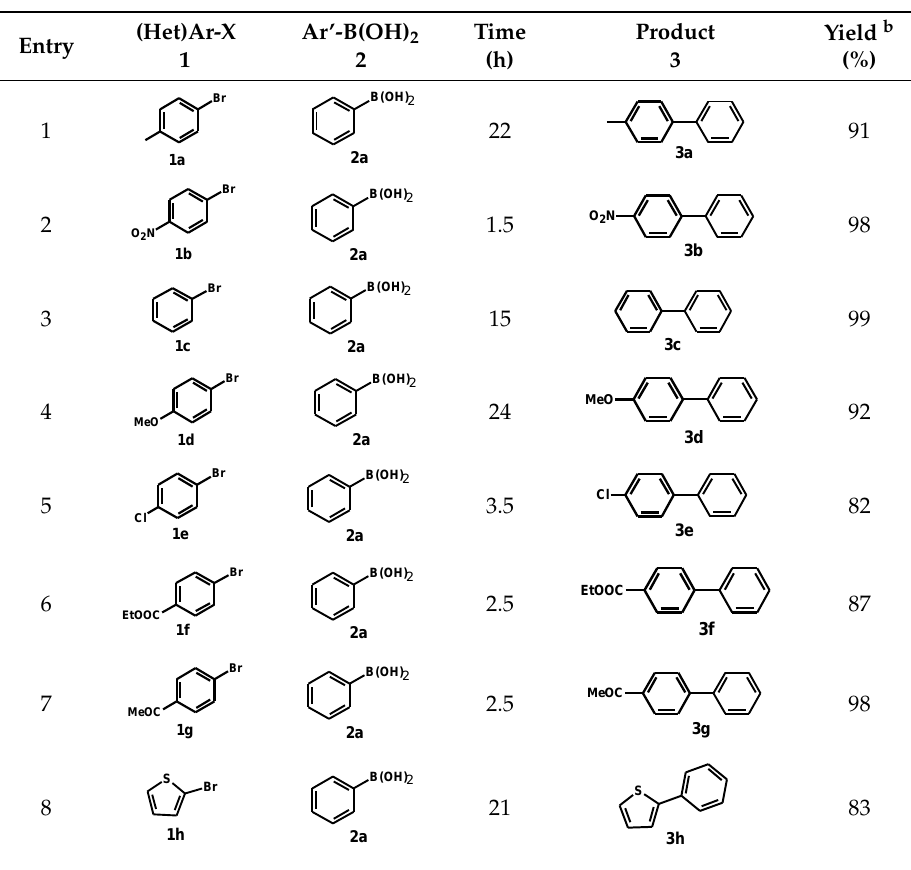
Table 2. Suzuki–Miyaura coupling reactions catalyzed by Pd/PVPy a .